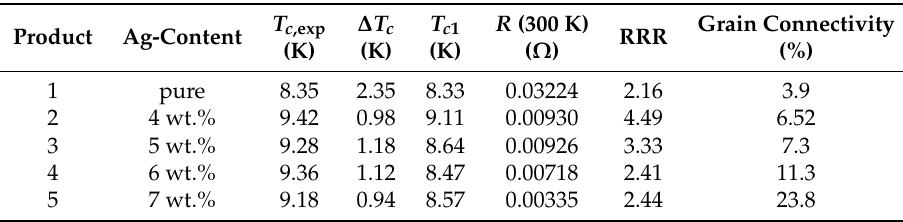
Superconducting and electric parameters of the studied FeSe products. RRR, ratio of residual